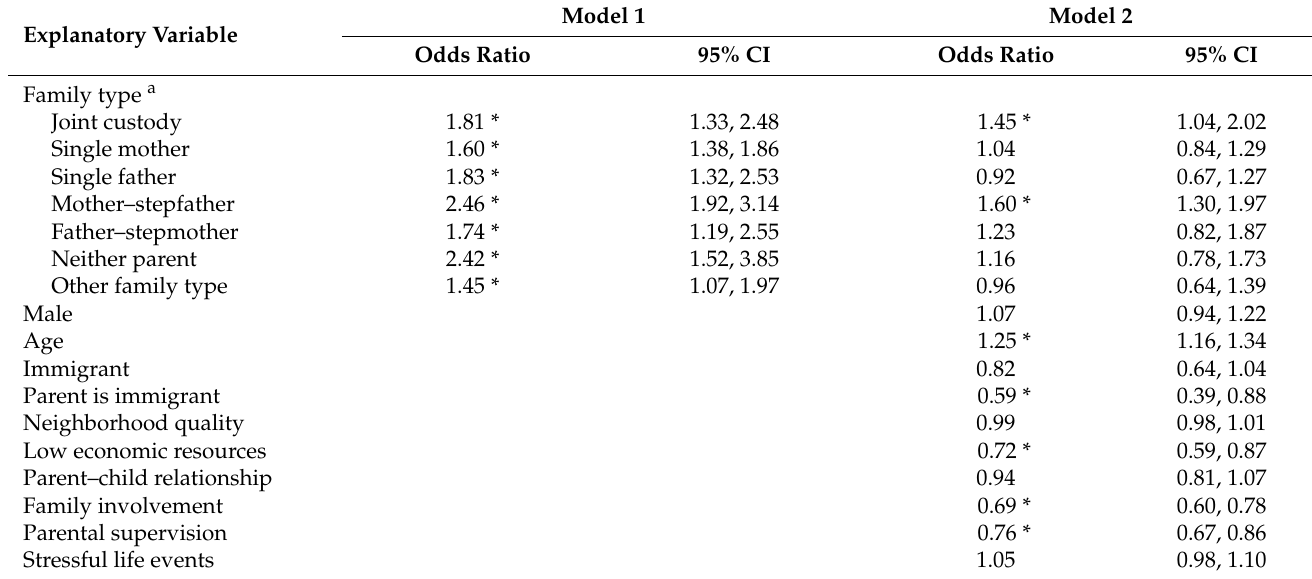
Table 2. Multilevel SEM of heavy alcohol use among adolescents, ISRD-2,